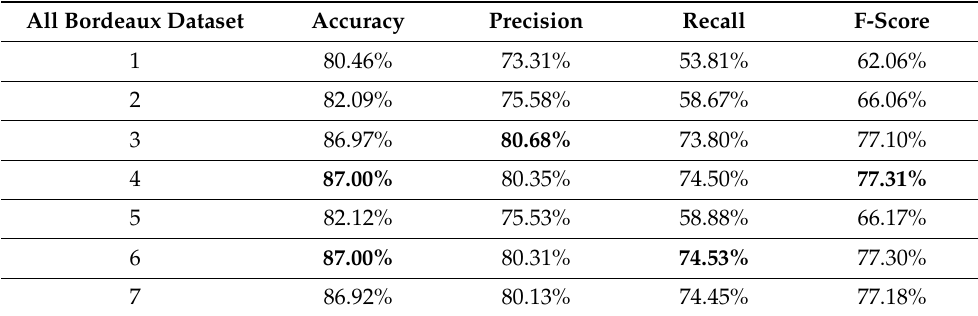
Table 4. Accuracy, precision, recall, and F-score with the SVM classifier in All-Bordeaux datasets. The highest results in each column are marked in bold.